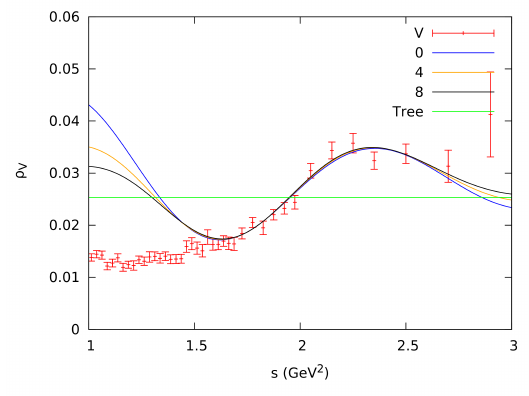
( s ) , fitted above 1.55 GeV 2 with the ansatz (14), Figure 5: Vector spectral function ρ V = 0,4,8, compared with the data points [ 16 ] for different values of λ V ( n = 3 ) ( m 2 ) , in FOPT, and the spectral ansatz parameters in f Table 3: Fitted values of α τ s = 1.55 GeV 2 , for different values of the power λ Eq. (14) with ˆ s 0